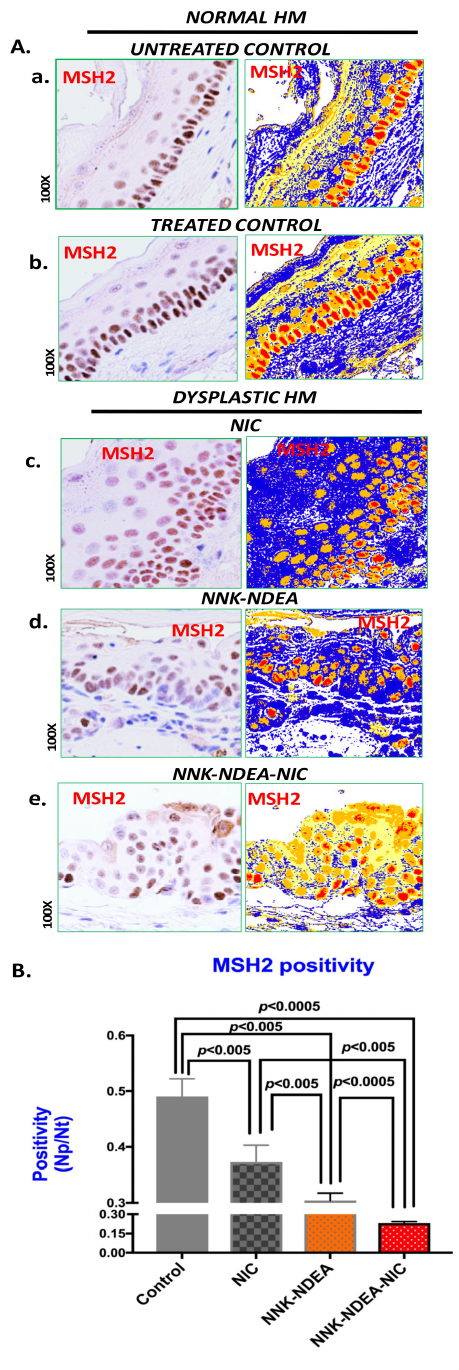
Figure 1. Chronic exposure to TS components decreases MSH2 protein levels and promotes dysplasia in murine HM. ( A ). IHC analysis for MSH2 (brown staining) and image analysis algorithm(s) (red: strong positive nuclear staining; orange: intense positive cytoplasmic staining; yellow: weak cyto- plasmic staining; blue: negative staining; by Image Scope software) of hypopharyngeal mucosa (HM) of C57Bl6J mice after 14 weeks of exposure to TS components nicotine (NIC), N -Nitrosamines (NNK- NDEA), or their combination (NNK-NDEA-NIC) and controls. ( a ) Untreated control, ( b ) Treated control (normal HM), ( c ) NIC-treated HM (mild dysplastic), ( d ) NNK-NDEA-treated HM (moder- ate dysplastic), ( e ) NNK-NDEA-NIC-treated HM (severe dysplastic) (original magnification 100 × ). ( B ). Graph depicts MSH2 nuclear positivity in murine HM-exposed TS components, compared with treated controls, by t -test with multiple comparisons using the Holm-Sidak method ( p < 0.05). (MSH2 nuclear positivity indicates the number of positive nuclei/number of total